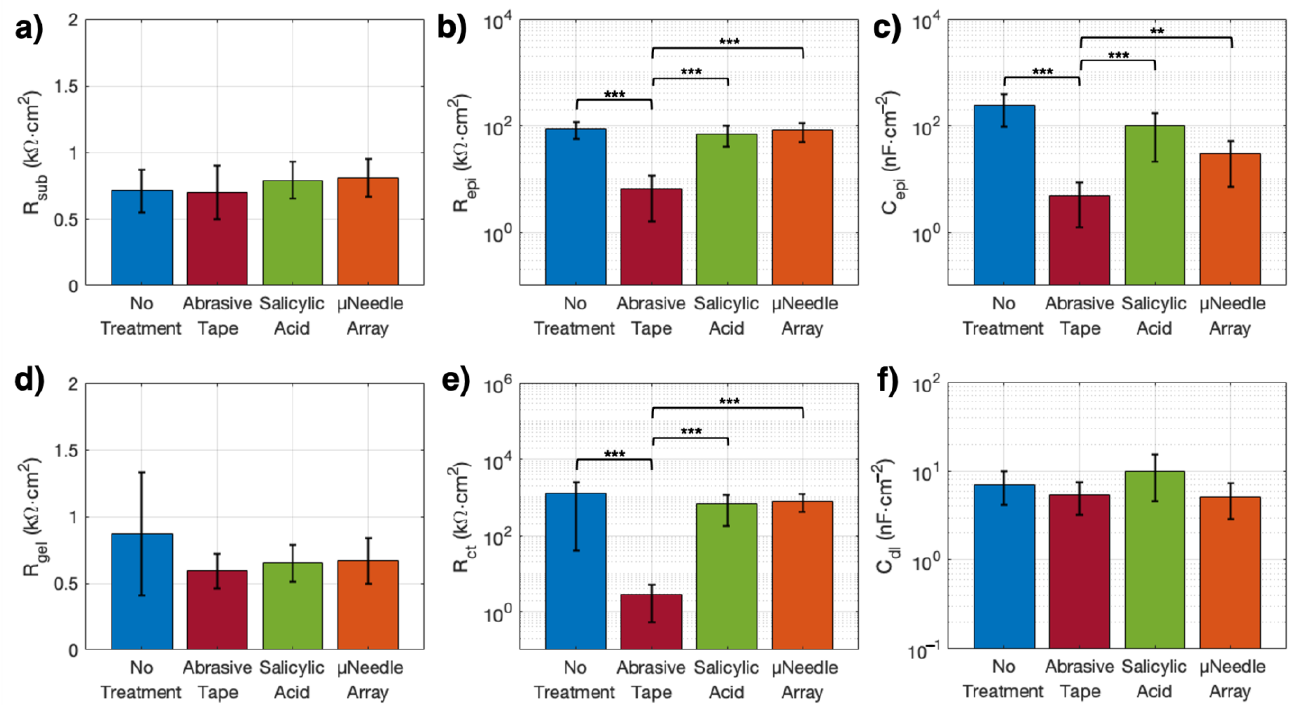
Figure 3. Area-normalized values of the fitted model parameters at t 0 . ( a – c ) Skin-level results at t 0 , for each treatment, including values of the ( a ) subcutaneous resistance, ( b ) epidermal resistance, and ( c ) epidermal capacitance. ( d – f ) Electrode-level results at t 0 , for each treatment, including values of the ( d ) gelled electrolyte resistance, ( e ) charge-transfer resistance, and ( f ) double-layer capacitance. Significance levels: (**) denotes p < 0.0167 and (***) denotes p < 0.00167.